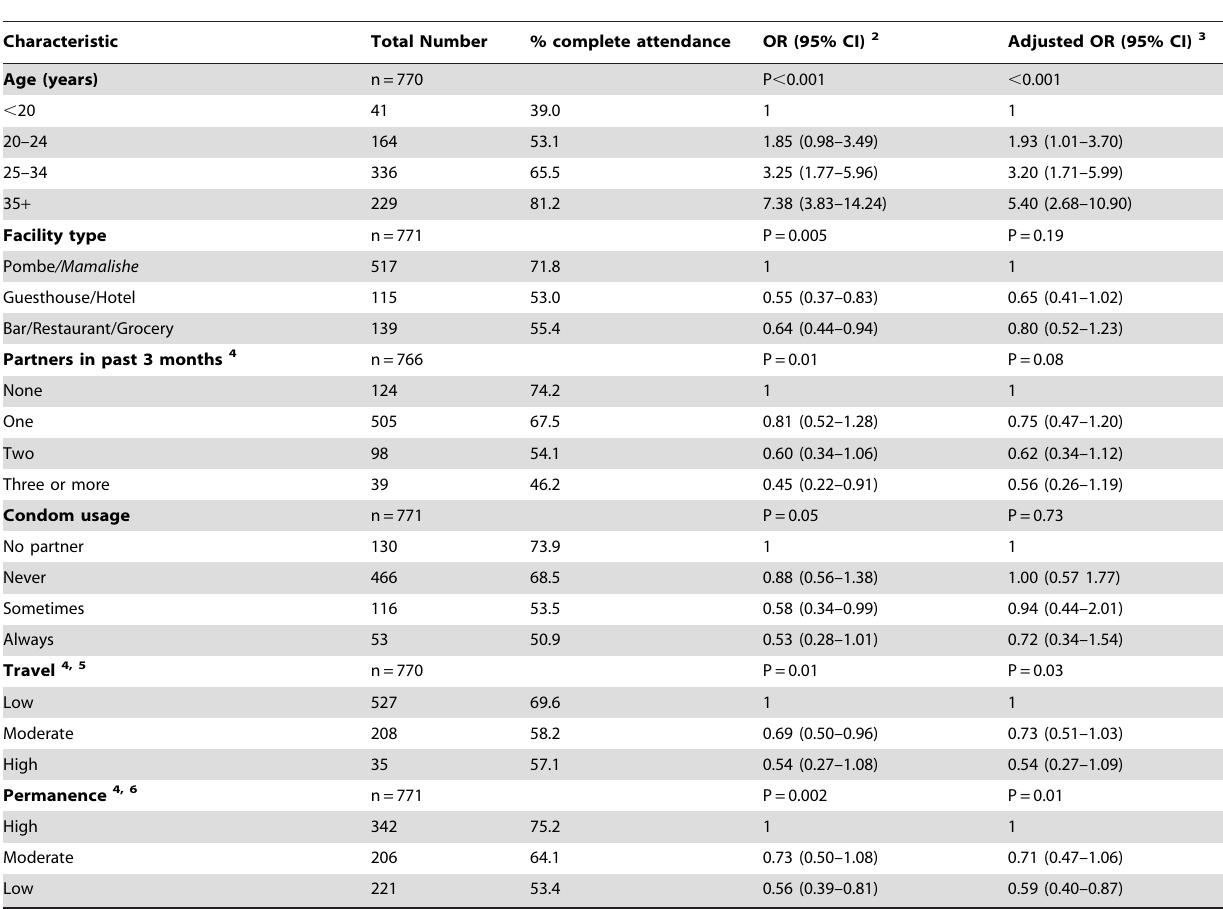
Table 5. Factors associated with re-attendance 1 among 771 eligible women attending at three months.